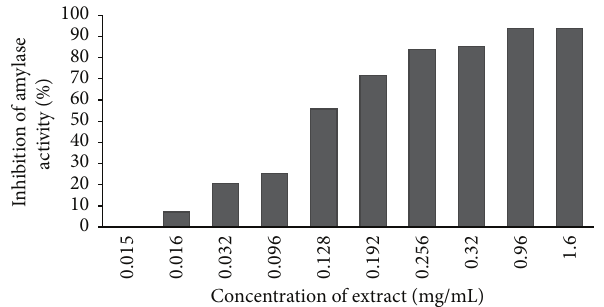
Figure 1: Amylase inhibitory activity of HFME in vitro .